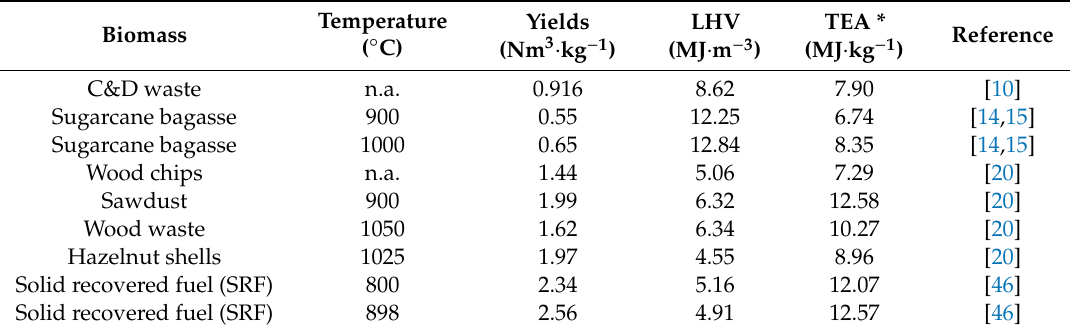
Table 9. TEA calculation for biomass